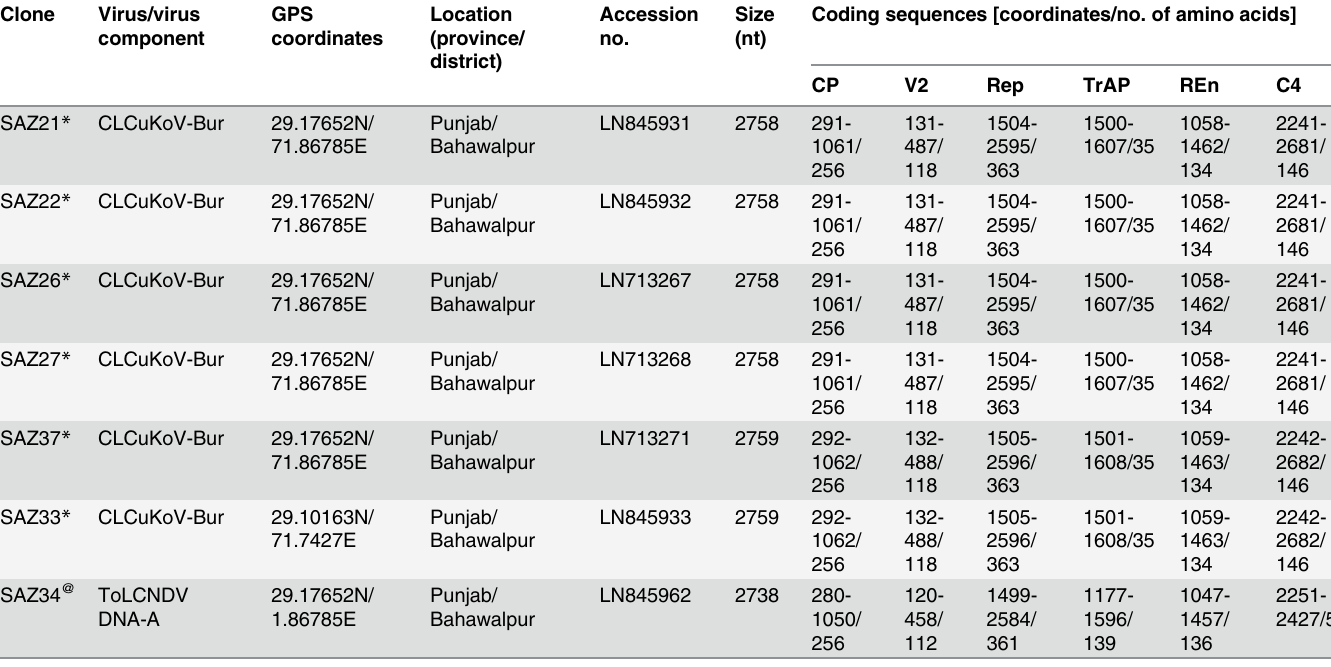
Table 2. Origins and features of monopartitebegomovirus and bipartite begomovirus DNA-A component clones